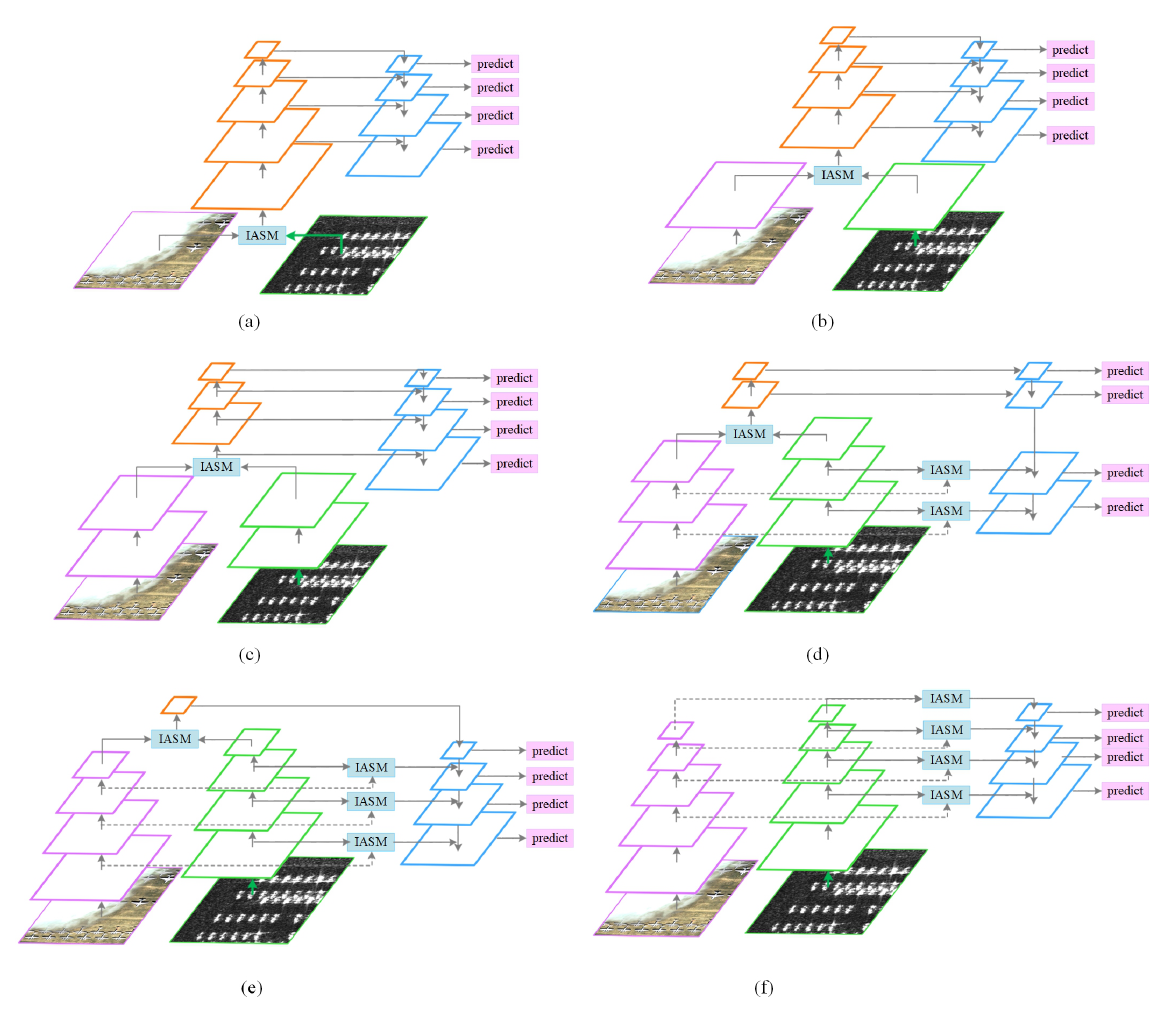
Figure 9. The multi-path IASM at different stages. ( a – f ) The fusion v.s. stages. It can be seen from Table 2 that with the increase of fusion stages, the inference time also increases. Input Fusion presents relatively low accuracy with the evaluation index of AP 50 being only 0.902. Compared with Input Fusion, Early Fusion extracts multi-module image features and simply fuses them, and the accuracy rate can be improved, but the evaluation index of AP 50 is only 0.911. Halfway Fusion extracts the features of the optical image and the SAR image in the first three stages of ResNet-34, and merges them together for further identification, the evaluation index of AP 50 is 0.925. Compared with Input Fusion and Early Fusion, Halfway Fusion has relatively high computational complexity and accuracy. Late Fusion fuses optical and SAR images in the five stages of ResNet-34, and then uses IASM to fuse the features of different channels. However, the evaluation index of AP 50 decreases to 0.919. Conducting an analysis, we will find that Halfway Fusion may benefit from the balance between the semantic information and low-level clues, so resulting in the best results among these